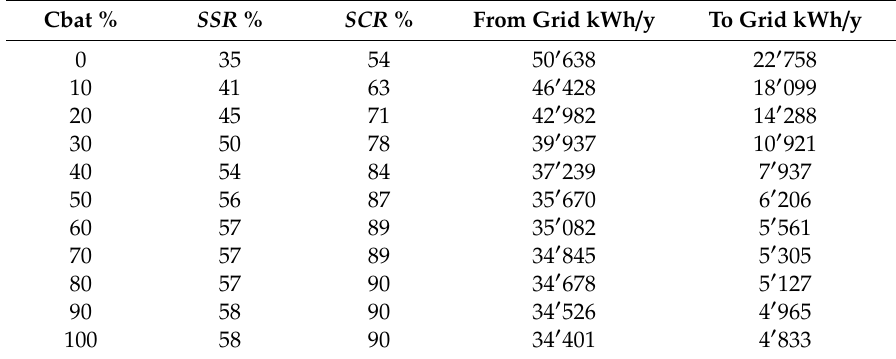
Table 7. Energy taken and injected into the grid at different capacity of the battery for the MC1. Cbat % SSR % SCR % From Grid kWh /